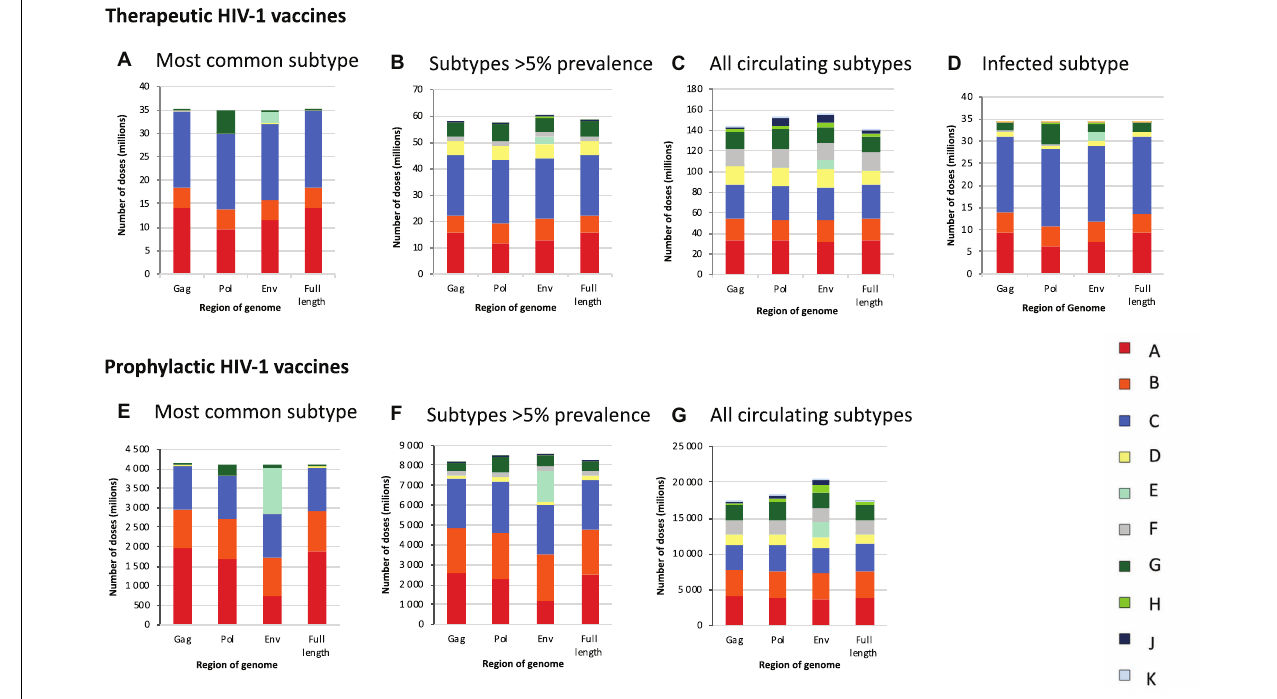
FIGURE 3 | Global estimates of the number of doses of subtype-specific therapeutic and prophylactic HIV-1 vaccines. Estimates of the number of doses of subtype-specific therapeutic (A–D) and prophylactic (E–G) HIV-1 vaccines. Estimates are stratified according to genome region ( gag , pol , env , and full length) and the number of subtypes against which people in each country are vaccinated, according to different scenarios, i.e., vaccinating people against the most common subtype in each country (A,E) , subtypes with a prevalence of > 5% in people living with HIV in each country (B,F) , all subtypes circulating in each country (C,G) , and the HIV-1 subtype with which HIV-positive people are infected (D) . Data underlying this figure is displayed in Table 1